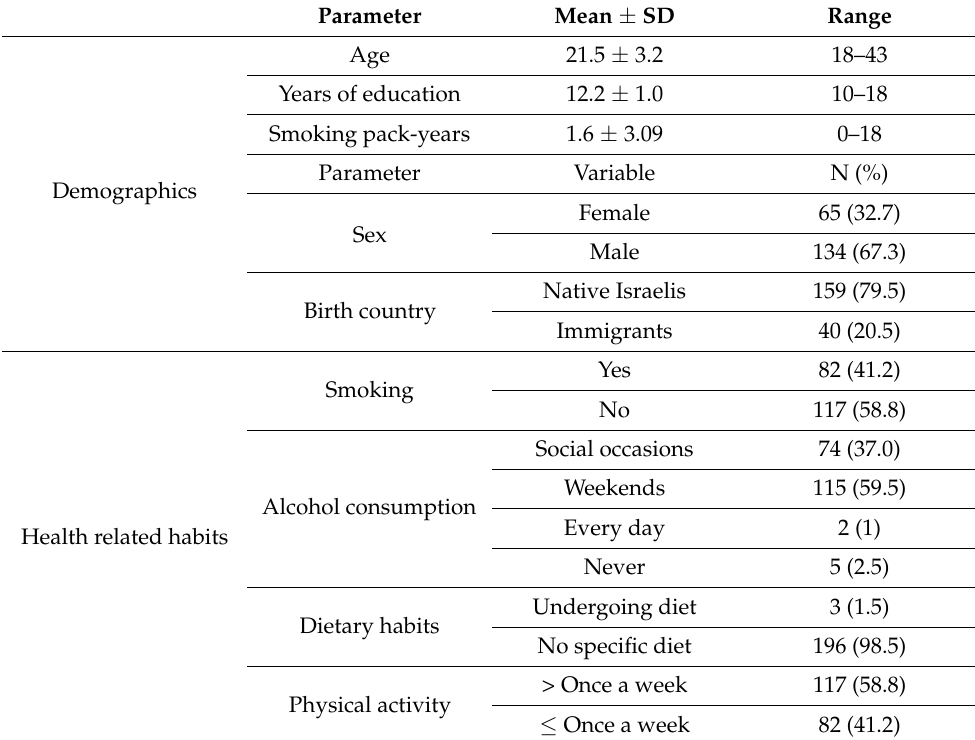
Table 1. Demographics, health-related habits, and dental status of the study